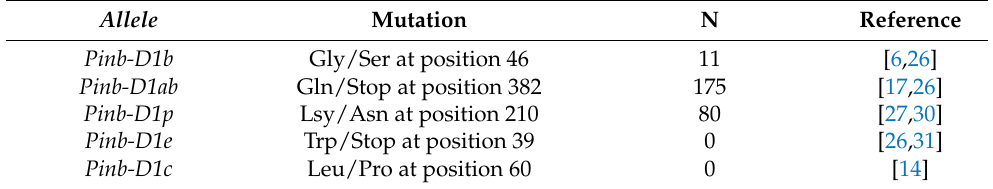
Table 1. List of Pinb-D1 alleles that were searched for specific restriction enzymes in our study. Allele